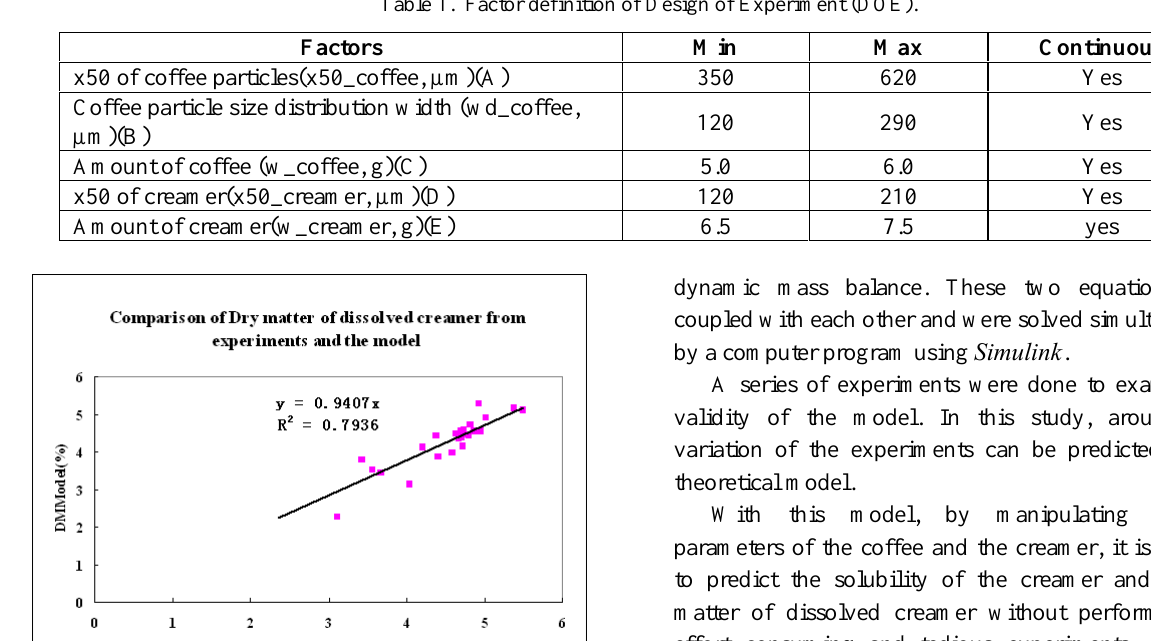
Table 1. Factor definition of Design of Experiment